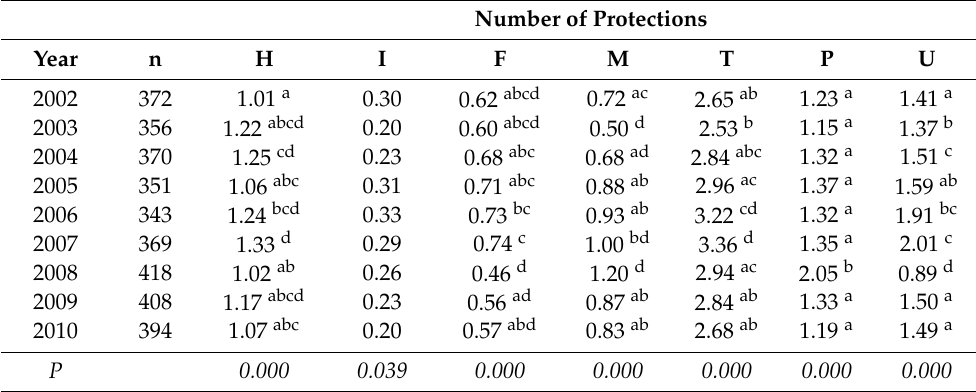
Table A9. Number of chemical protections in 2002–2010; average of three tillage systems and eleven crops. Number of Protections